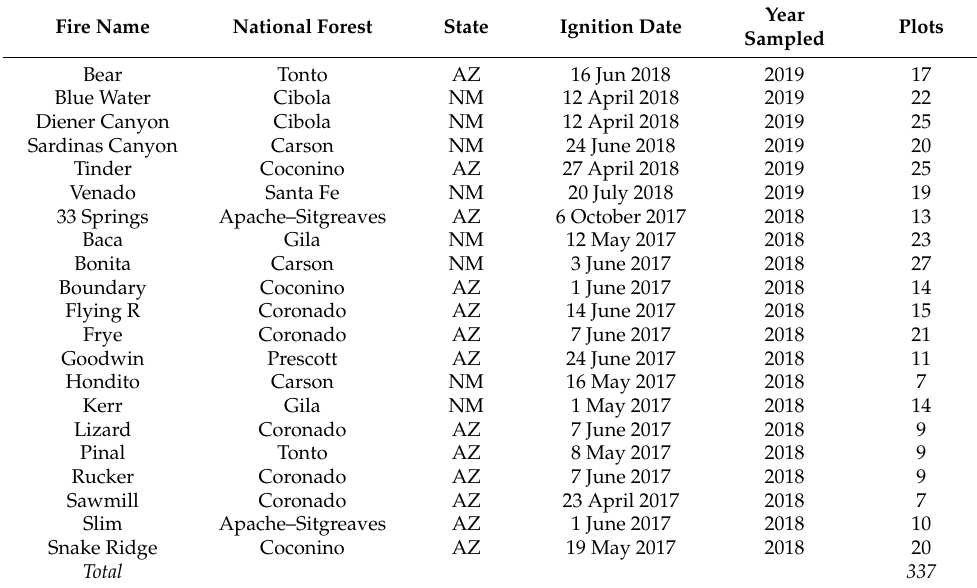
Figure 1. Locations of 2017 and 2018 fires where field plots were located. Table 1. Locations and number of plots on each fire sampled.